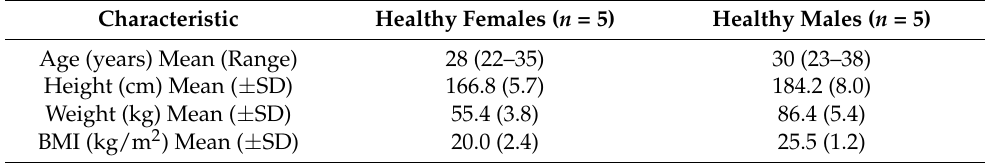
Table 1. Characteristics of EVV Study